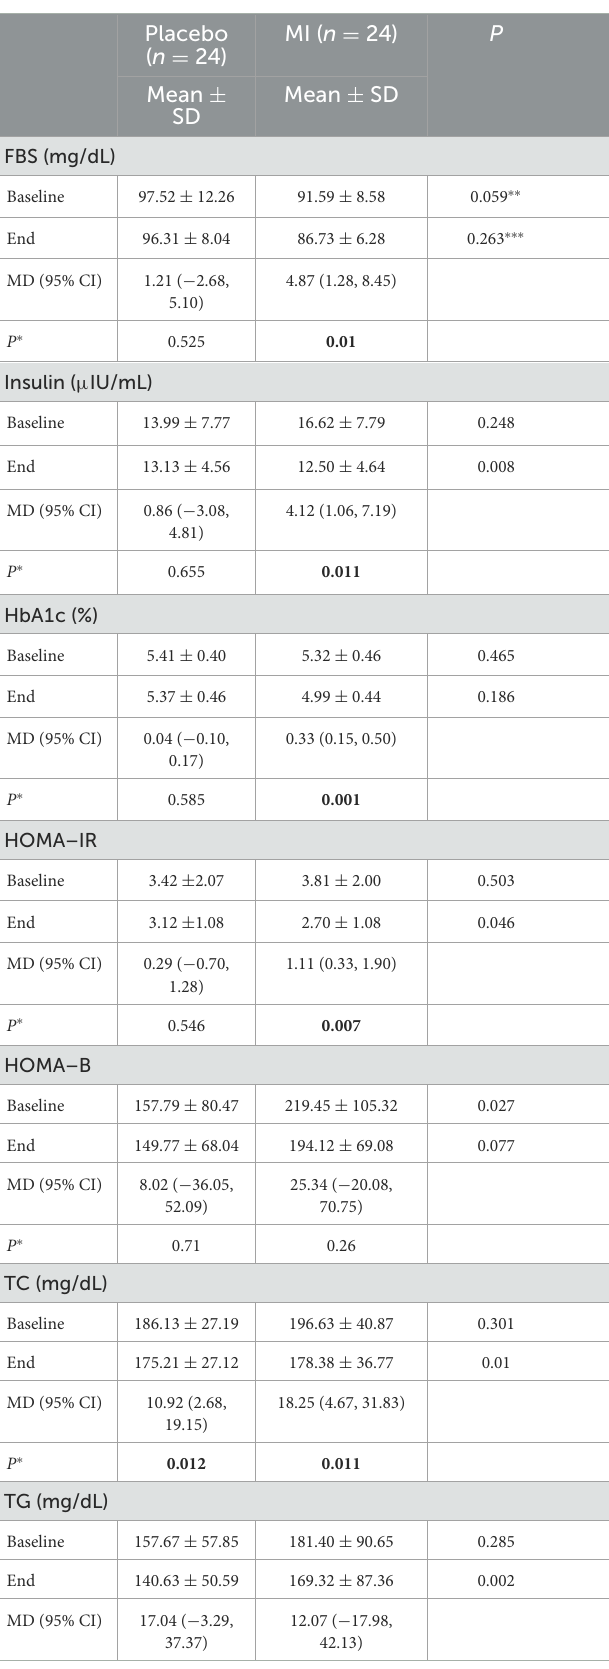
TABLE 3 Cardiometabolic indices and liver parameters of the study participants throughout the